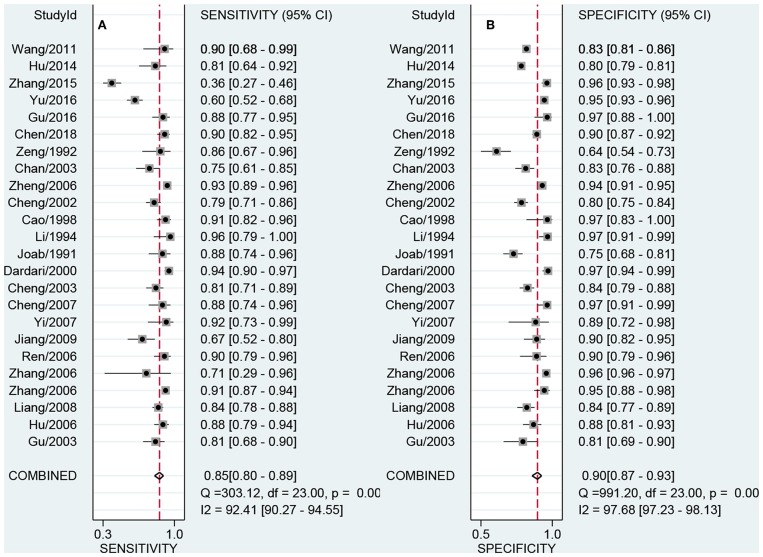
Forest plot of pooled sensitivity (A) and specificity (B).